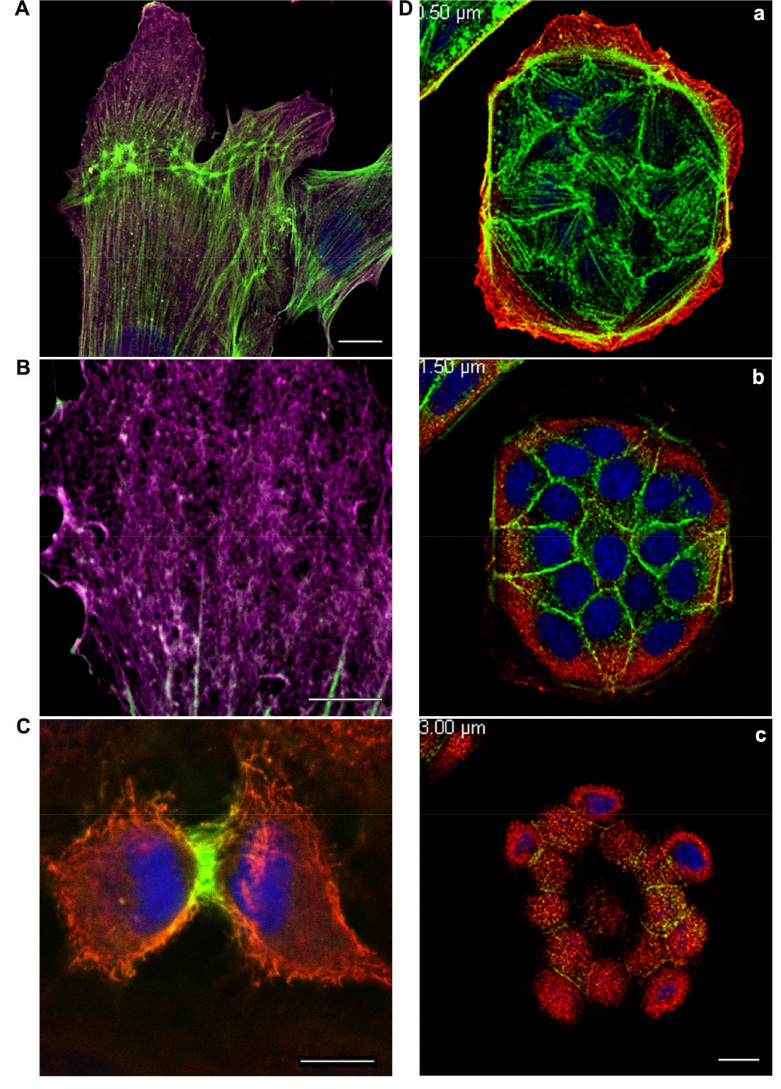
Figure 1. ( A , B ): β -actin and γ -actin display distinct distribution at the leading edge of fibroblasts moving towards the wound. An experimental wound was performed by scratching a monolayer of normal human subcutaneous fibroblasts. The cells were fixed and stained for cytoplasmic actins three hours later after scratching. β -actin bundles (green) and γ -actin network (purple) are pronounced in the motile cells. Laser scanning microscopy (LSM). Scale bars: ( A ) 10 µ m; ( B ) 5 µ m. ( C ): Segregation of cytoplasmic actin isoforms in cytokinesis of normal mitotic epithelial cells. β -actin and γ -actin are spatially segregated in cytokinesis of epithelial HaCaT cells. β -actin (green), γ -actin (red), and DNA (blue). LSM. Scale bar: 5 µ m. ( D ): β -actin and γ -actin are localized in different structures and cell compartments. MDCK epithelial cells were cultivated for 3 days, fixed, and stained for cytoplasmic actins. β -actin (green) is present in basal bundles ( a ) and cell–cell contacts ( b ). γ -actin (red) is present in lamellar ( a ) and dorsal/cortical ( b , c ) networks. LSM. Scale bar: 10 µ